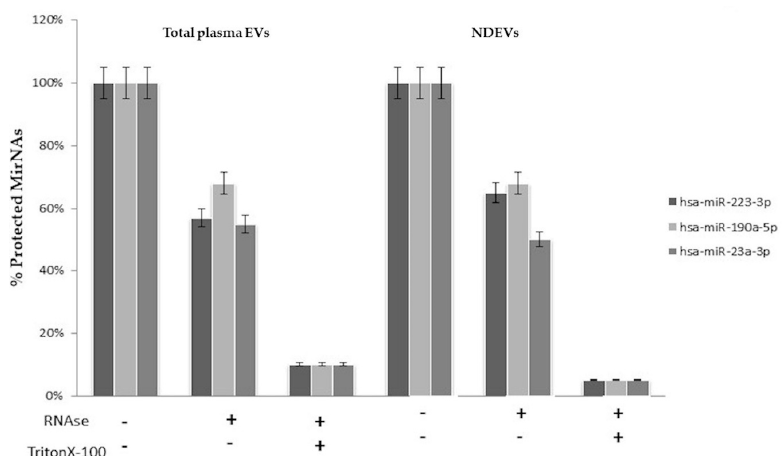
Figure 6 . RNase protection assay. The miR-223-3p, miR-190-5p and miR-23a-3p were quantified by q-PCR in total and neural-derived plasma EVs. EVs were treated with or without RNase I and / or Triton X-100 ( n = 4).